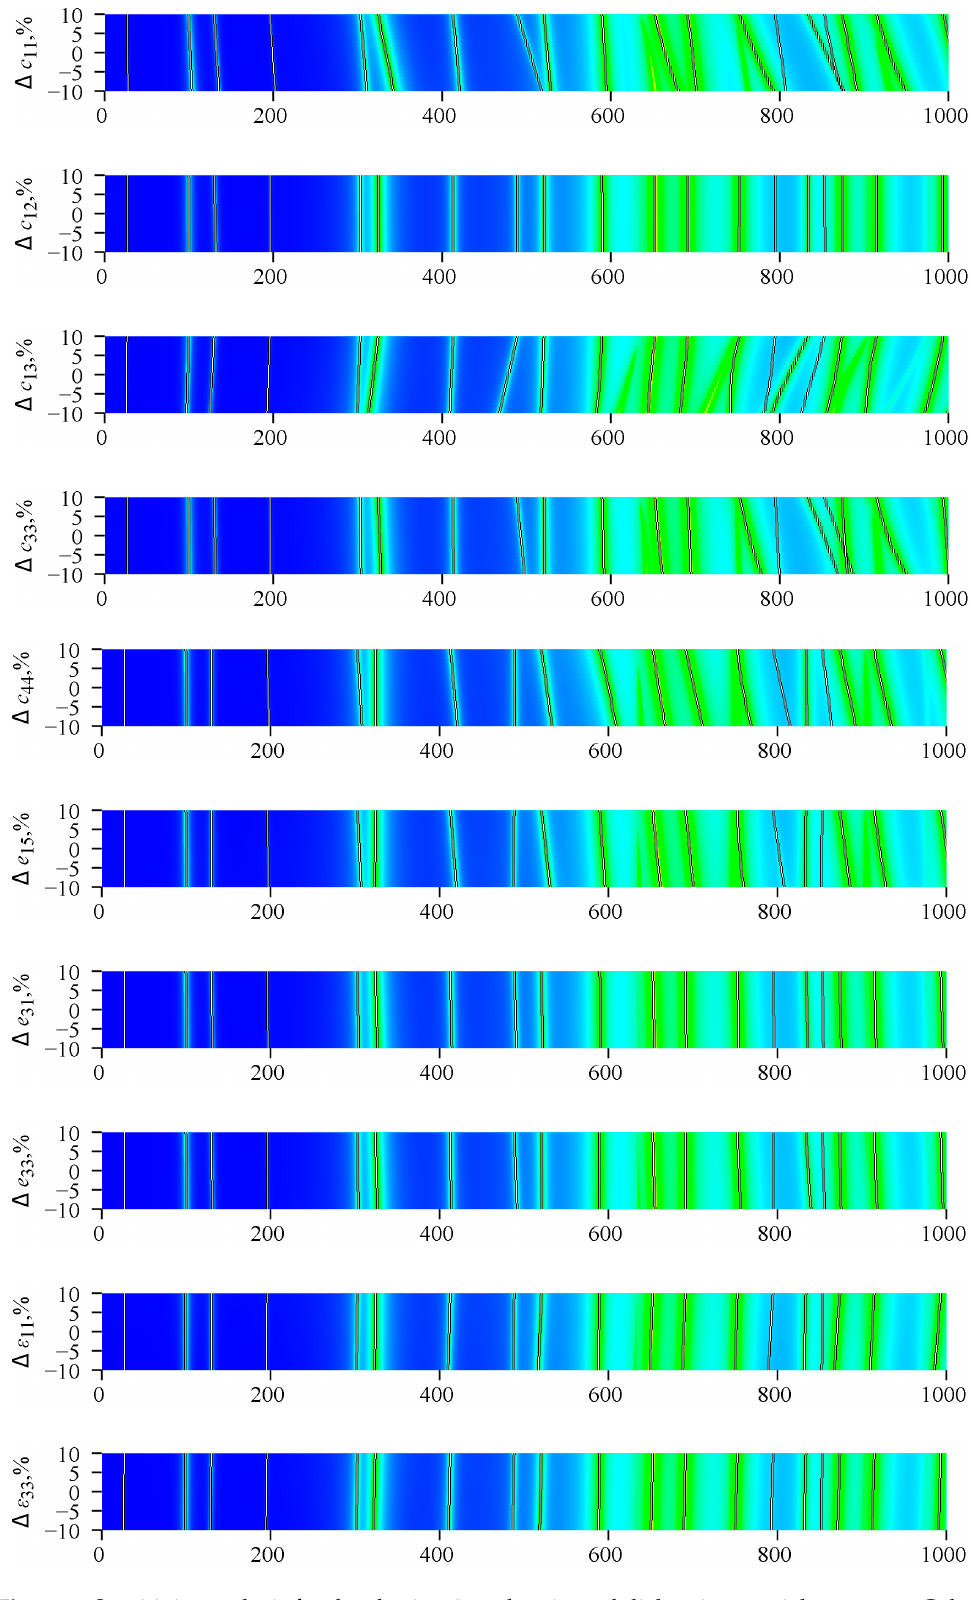
Figure 4. Sensitivity analysis for the elastic, piezoelectric, and dielectric material constants. Color maps correspond to the value of the real part of the electrical impedance R . The black lines with different slopes correspond to the local maximums of R .